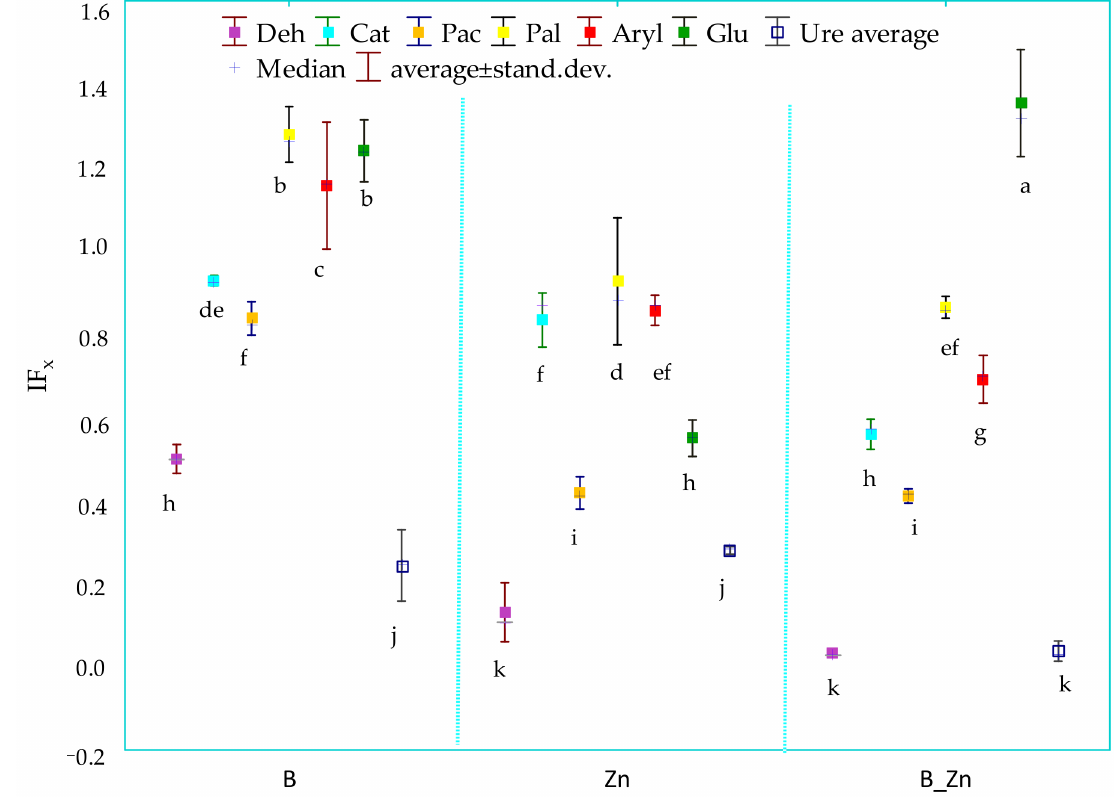
Figure 1. The coefficient of the influence of xenobiotics (IF X ) on the activity of dehydrogenases (Deh), catalase (Cat), urease (Ure), acid phosphatase (Pac), alkaline phosphatase (Pal), arylsulfa- tase (Aryl), and β -glucosidase (Glu) in unsown soil contaminated with B, and Zn 2+ , B + Zn 2+ ; B—bisphenol A; Zn—zinc ion (Zn 2+ ). Homogeneous groups denoted with letters (a–k) were calcu- lated for all